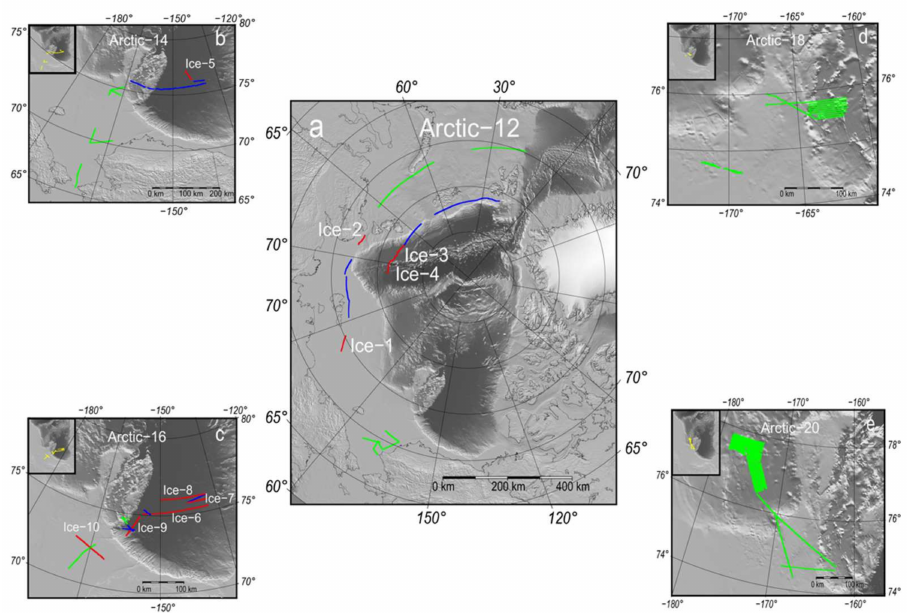
Figure 1. Ship track marine gravity used in the study. The green, blue, and red lines indicate gravity survey lines in an ice-free, a moderately ice-covered, and concentrated ice-covered region, respectively.